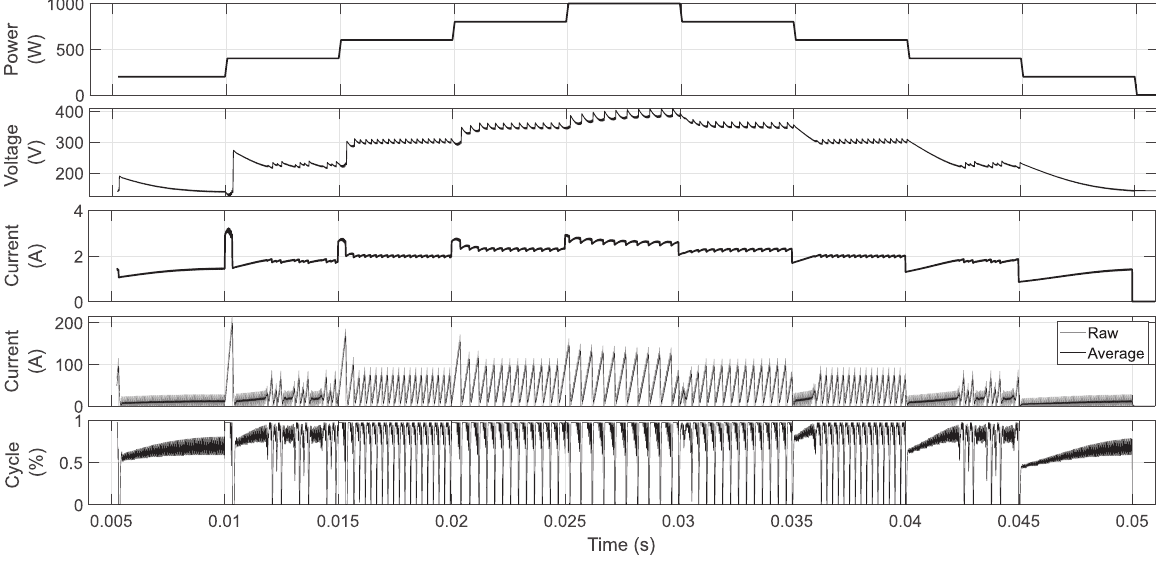
Figure 13. CPL sweep in the closed-loop operation of the Boost converter. The duty cycle reaches the upper limit (set to 0.95), and it is not possible to compensate for the small oscillations in output voltage and current. This is an inherent characteristic of the Boost